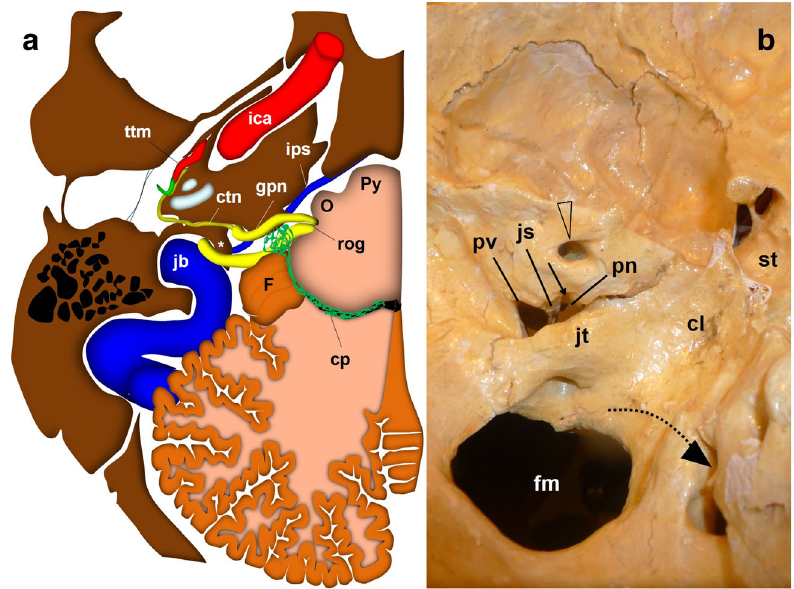
Fig. 2 The glossopharyngeal nerve (gpn), cisternal portion. a Schematic drawing of a transversal slice at the level of the medulla oblongata (view fromabove).Thegpnexits themedullaattheretro-olivarygroove(rog)and crosses through the cerebellomedullary cistern to the jugular foramen. Within the cistern, it lays below and in front of the choroid plexus (cp) of the fourth ventricle and the cerebellar flocculus (F). The glossopharyngeal nerve exits the skull medial and anterior to the jugular spine (*). At that level, it is closely related to the inferior petrosal sinus (ips). The glossopharyngeal nerve crosses first over the sinus to be anterior to the sinus at the extracranial verge of the jugular foramen, posterior to the